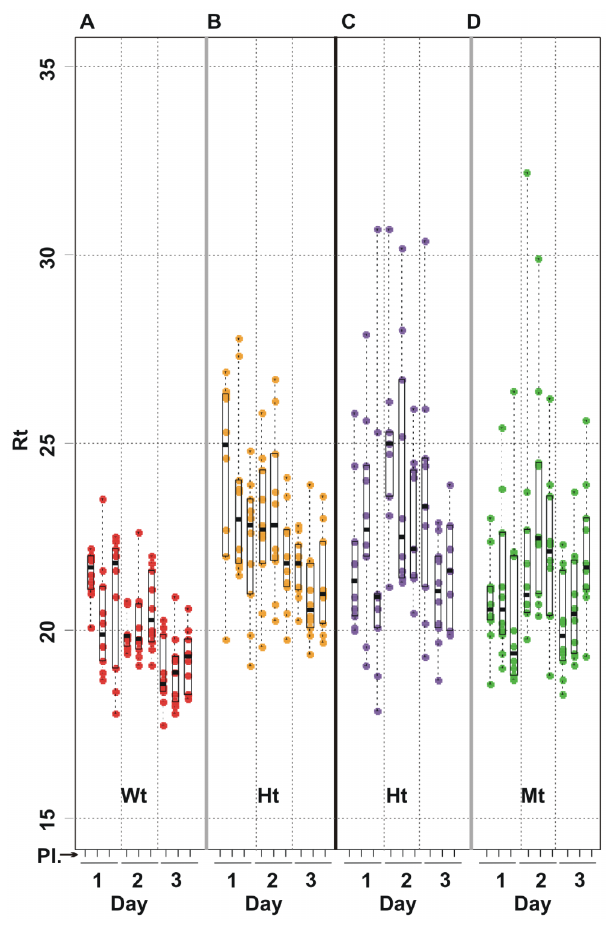
Figure 5. Detail view of homozygote vs. heterozygote RAM response times. Panels A and B show the RAM response times (Rt) for Wt and heterozygote DNA samples hybridized to the Wt-detecting C- probe. Panels C and D show the RAM response times for Ht and Mt DNA samples hybridized to the Mt-detecting C-probe, respectively. The data are marked with interquartile graphic boxes; dotted lines extend to maximum and minimum signals and a bar marks the Rt median value.